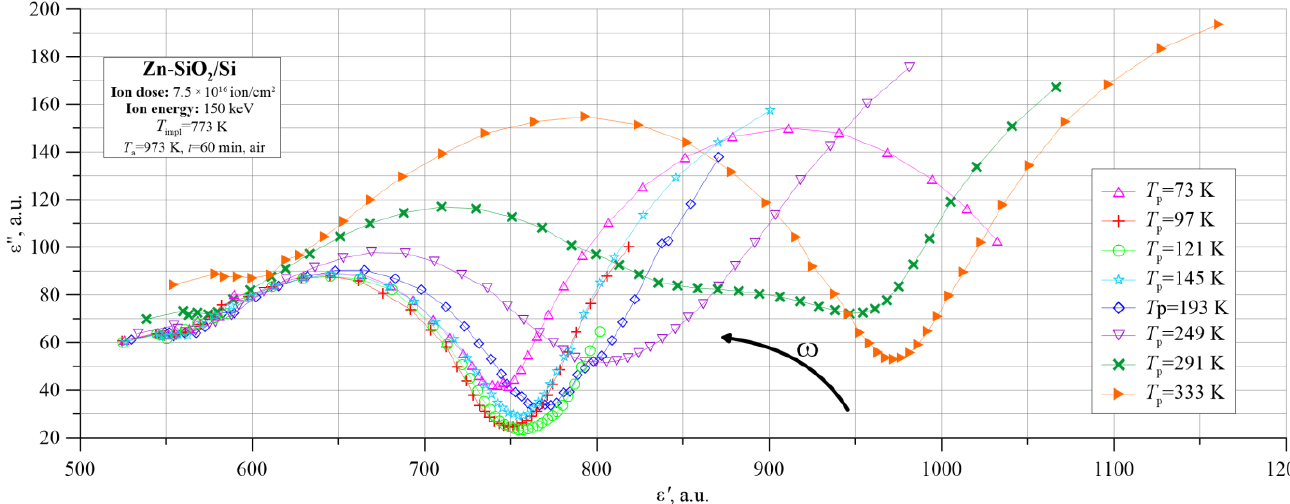
Figure 15. Cole–Cole diagram of Zn-SiO 2 /Si nanocomposite obtained in the conditions of “hot” implantation (150 keV, 7.5 × 10 16 ion/cm 2 , T impl = 773 K) and annealed at the temperature of T a = 973